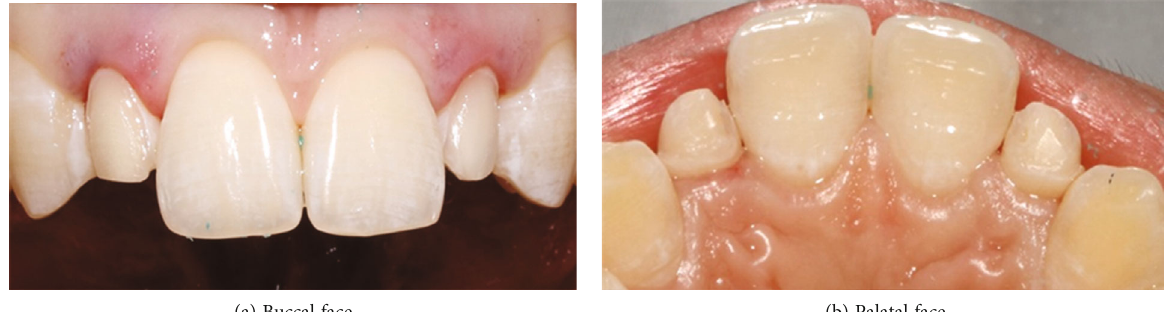
Figure 5: Preparation design.